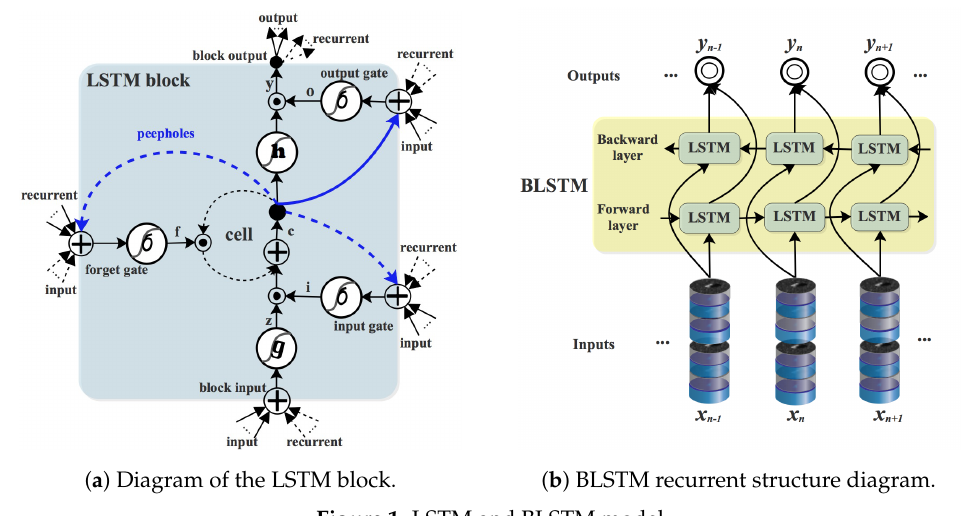
Figure 1. LSTM and BLSTM